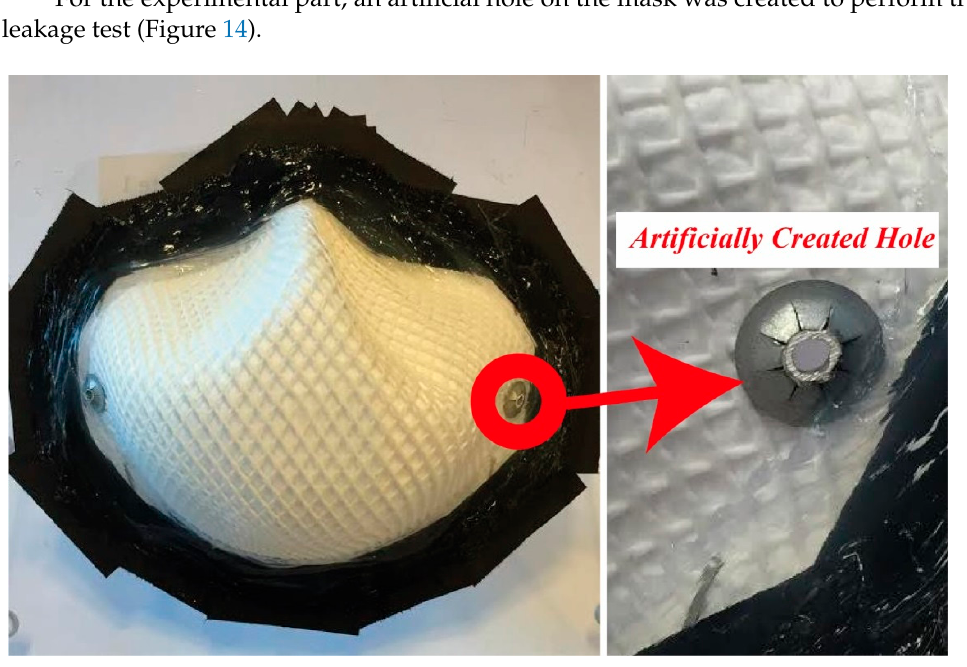
Figure 14. The holes are created to evaluate leakage performance of the mask [61].